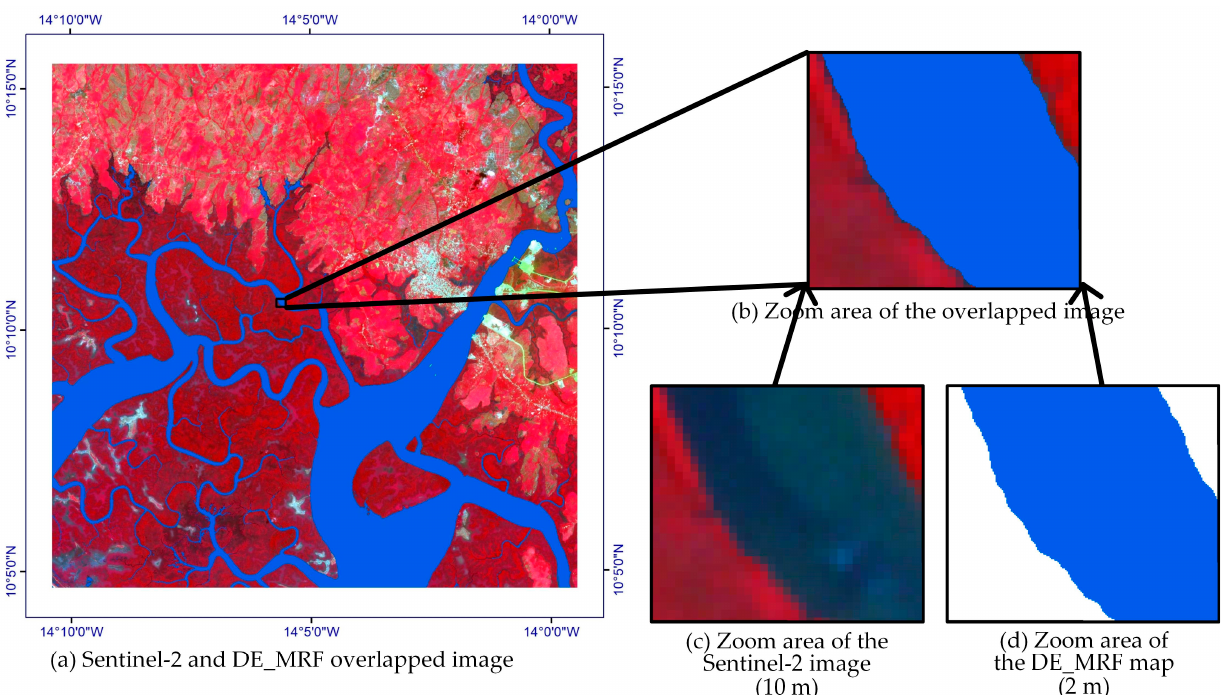
Figure 9. 2 m resolution DE_MRF surface water map (blue indicates surface water, and white indicates land) overlapped with the Sentinel-2 image in the Dangara region in Guinea. The false color image is composited with VNIR-red-green as RGB.